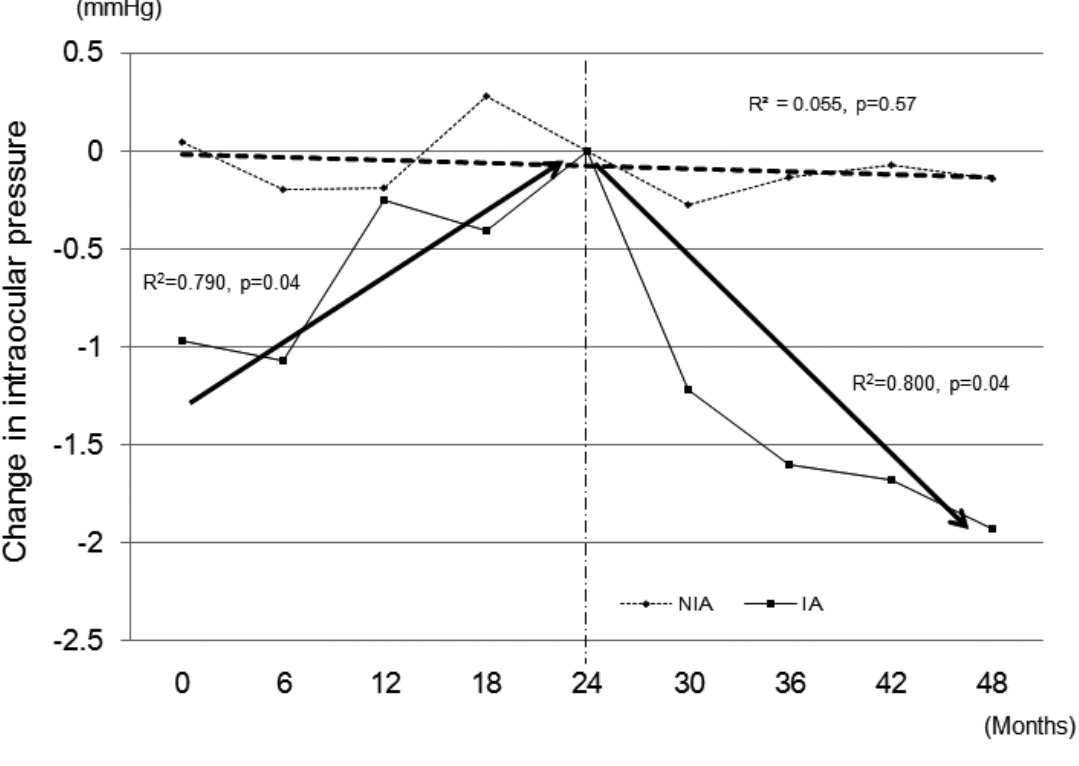
Figure 6. A change in the intraocular pressure at 24 months after the start of the study was defined as zero mmHg. IA: Internet access group, NIA: non-Internet access